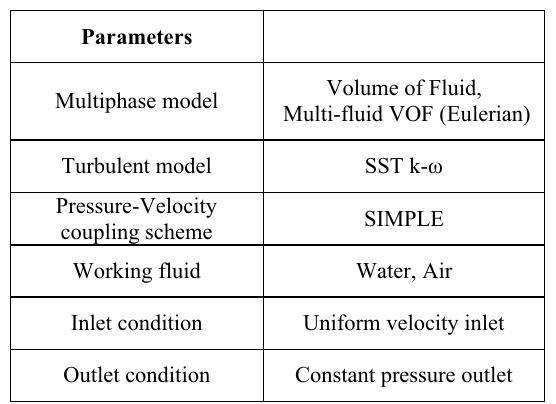
Table 1. Numerical parameters.